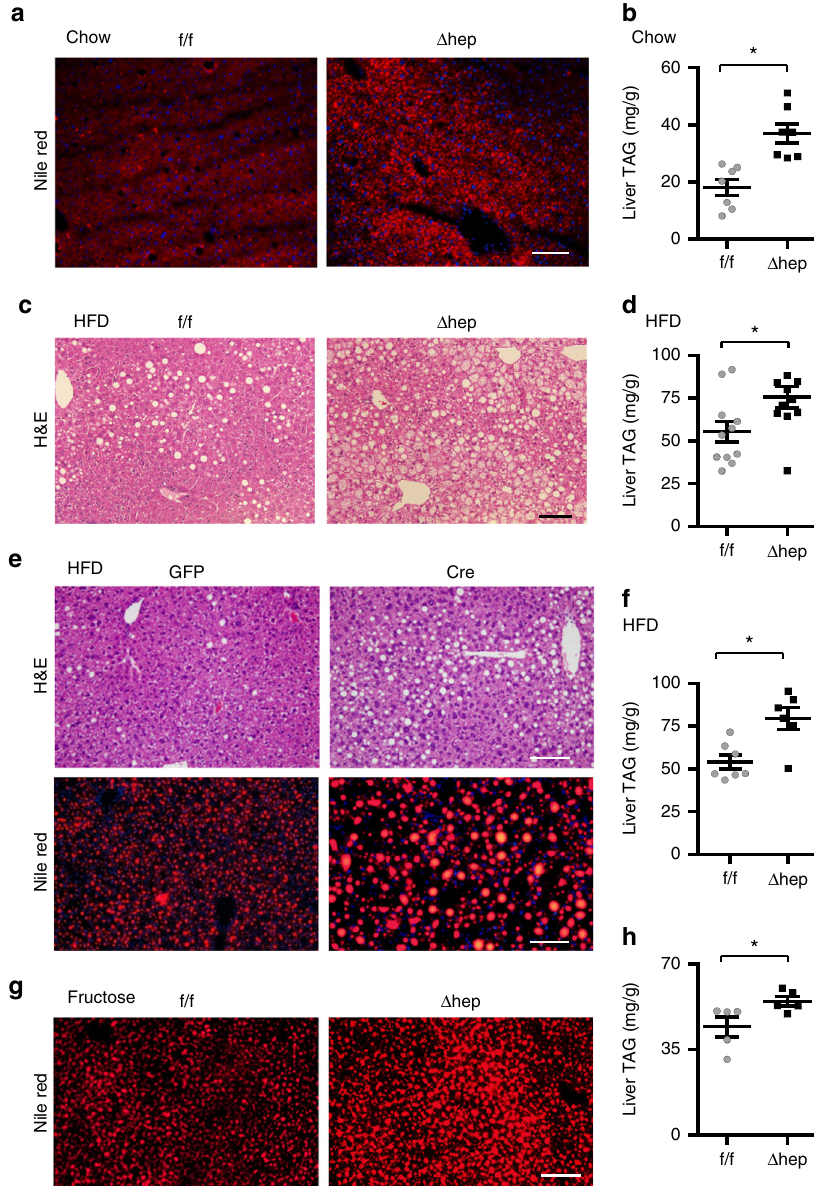
Fig. 3 Hepatocyte-speci fi c deletion of Snail1 promotes NAFLD. a , b Snail1 fl ox/ fl ox ( n = 7) and Snail1 Δ hep ( n = 7) males (18 weeks) were fed a normal chow diet. Livers were isolated under non-fasted conditions. a Representative Nile red staining of liver sections. b Liver TAG levels (normalized to liver weight). c , d Snail1 fl ox/ fl ox ( n = 11) and Snail1 Δ hep ( n = 11) male littermates were fed a HFD for 10 weeks. c Representative H&E staining of liver sections. d Liver TAG levels (normalized to liver weight). e , f Snail1 fl ox/ fl ox males were fed a HFD for 6 weeks and transduced with AAV-TBG-GFP ( n = 7) or AAV-TBG-Cre ( n = 6) vectors for 4 weeks. e Representative H&E or Nile red staining of liver sections. f Liver TAG levels (normalized to liver weight). g , h Snail1 fl ox/ fl ox ( n = 5) and Snail1 Δ hep ( n = 5) males were fed a fructose diet for 10 weeks. Scale bars: 100 µ m. Data are represented as mean ± SEM. * p < 0.05, two-tailed unpaired Student ’ s t